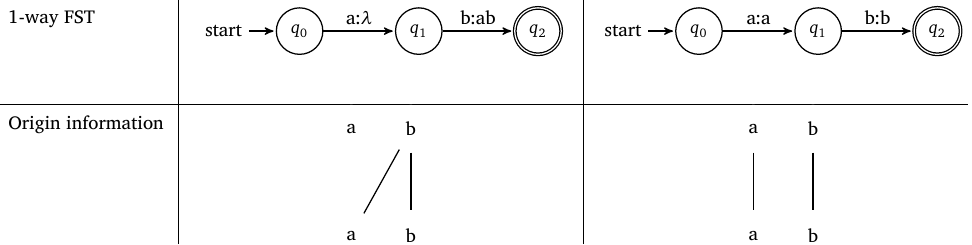
Figure 4: Pair of 1-way FSTs for the function f ab and the origin information cre- ated by them for the mapping ab !